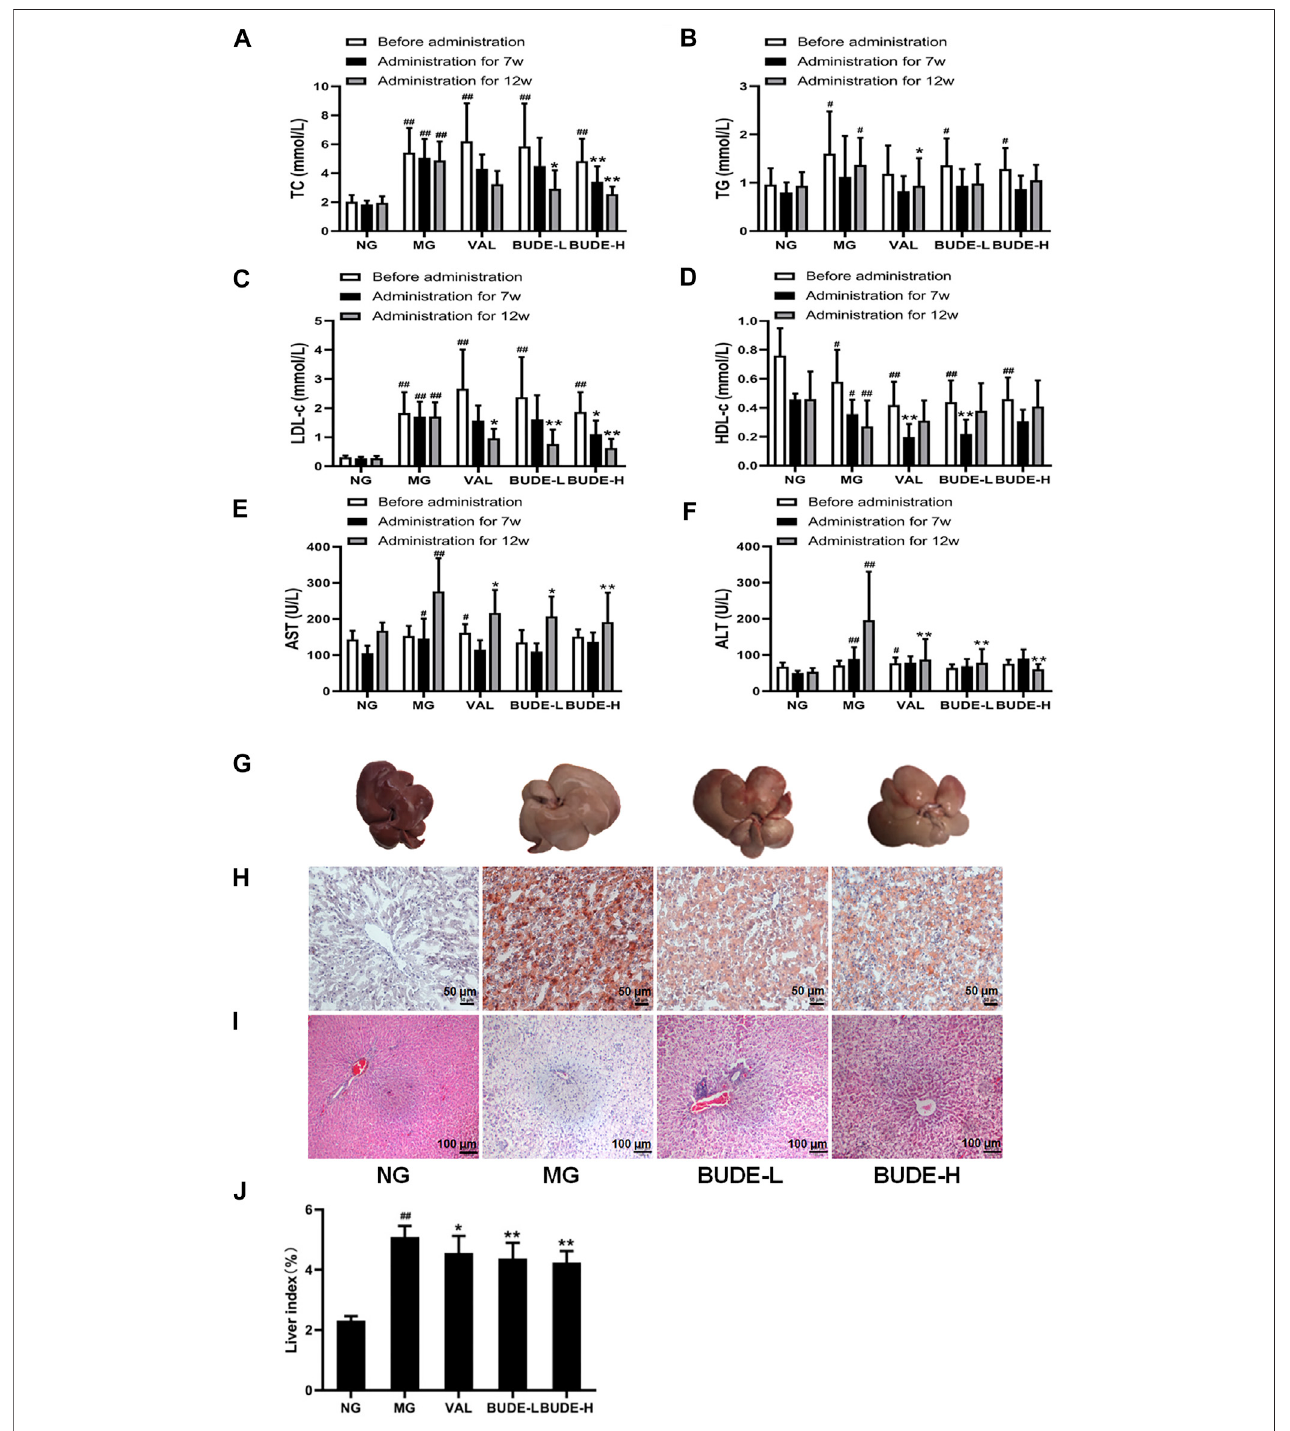
FIGURE 3 | Changes of blood lipid, serum transaminase, and liver pathological. (A) Changes in the serum total cholesterol (TC). (B) Changes in the serum triglyceride (TG). (C) Changes in the serum low density lipoprotein cholesterol (LDL-c). (D) Changes in the serum high density lipoprotein cholesterol (HDL-c). (E) Changes in the serum aspartate aminotransferase (AST). (F) Changes in the serum alanine aminotransferase (ALT). (G) Liver gross morphology. (H) Oil red O staining of liver under magni fi cation × 100 (I) Representative graph ( × 100) of hematoxylin and eosin staining of liver (J) Liver index. Compared with the normal control group # p < 0.05, ## p < 0.01; compared with the model control group * p < 0.05, ** p < 0.01, n (cid:2) 7 – 10.